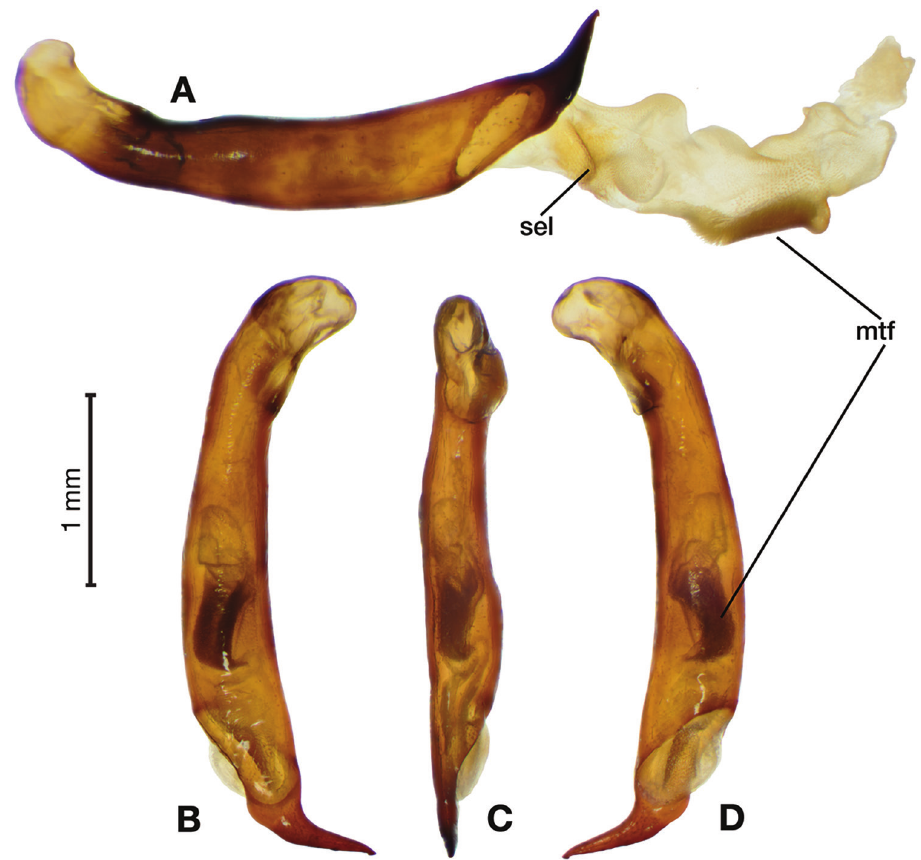
Figure 27. Digital images of male genitalia of Catascopus ( s. str. ) sauteri Dupuis. A right lateral aspect, endophallus everted B right lateral aspect C ventral aspect D left lateral aspect. Legend: mtf microtrichial field sel scleritization of endophallic lobe (fully visible from left lateral